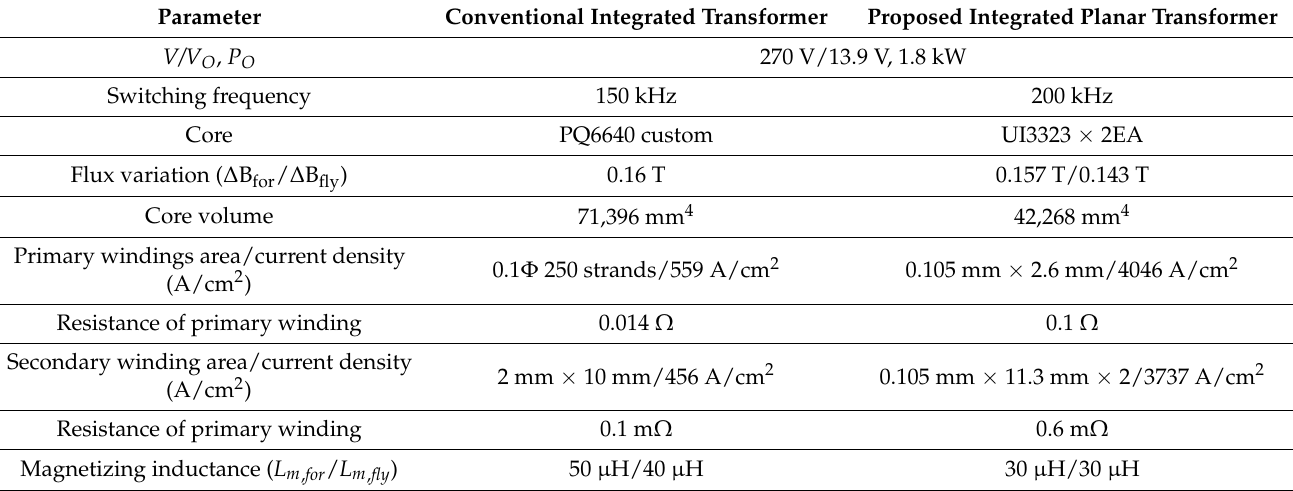
Table 1. Design results of the integrated planar